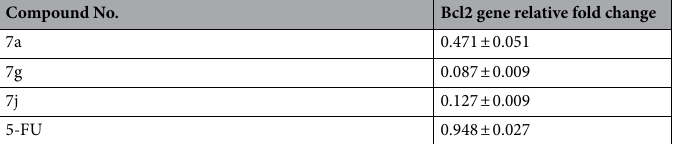
Table 3. Relative fold change in Bcl2 gene expression in Caco-2 cells treated with the selected Passerini adducts (0.06 µM for 72 h). *All the values are expressed as mean ± SEM. 5-FU stands for 5-fluorouracil.